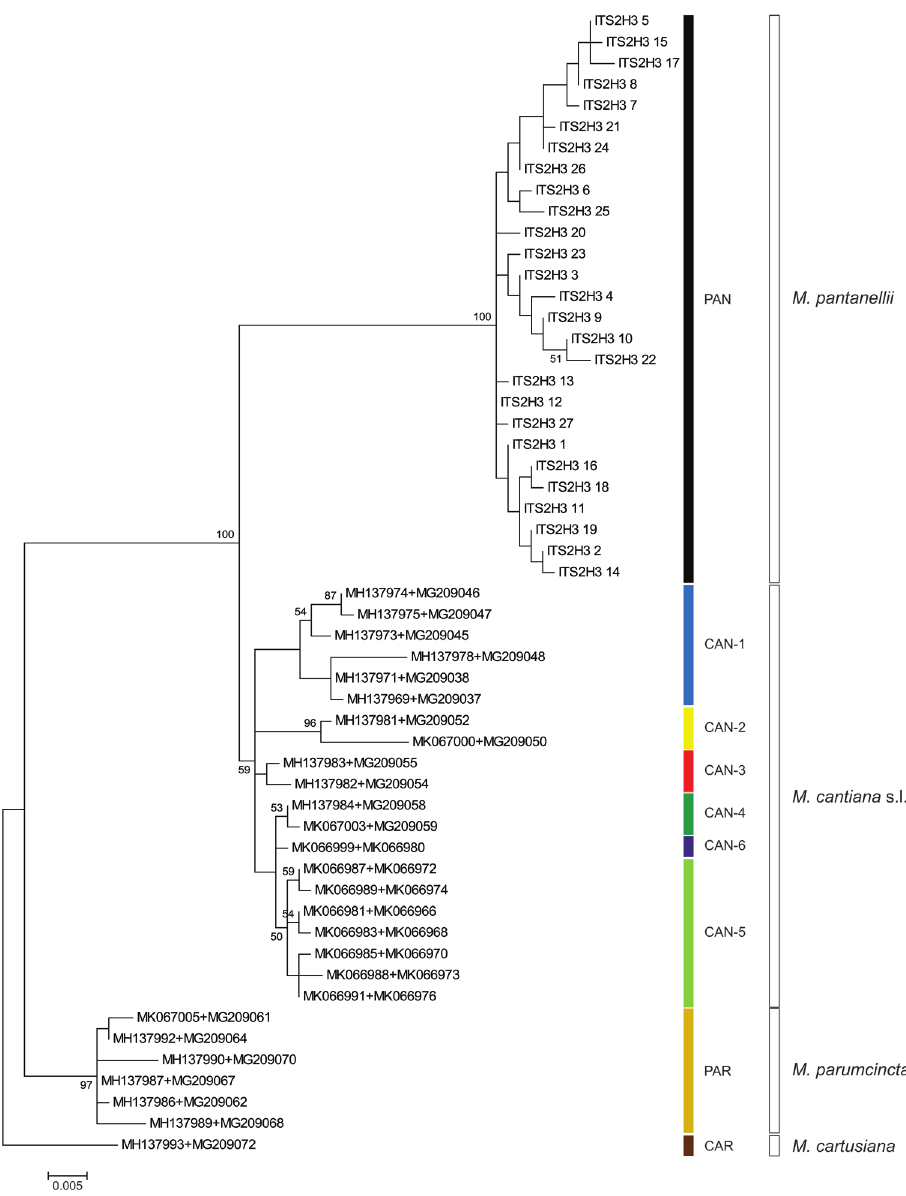
Figure 3. Maximum Likelihood (ML) tree of concatenated ITS2 and H3 common sequences of Monacha pantanellii (see Table 4). New ITS2 and H3 sequences of M. pantanellii (Table 1) were compared with ITS2 and H3 sequences of M. cantiana s. l. and M. parumcincta obtained from GenBank (Tables 2, 4). Numbers next to branches indicate bootstrap support above 50% calculated on 1000 replicates (Felsenstein 1985). The tree was rooted with M. cartusiana concatenated sequences obtained from GenBank (Table